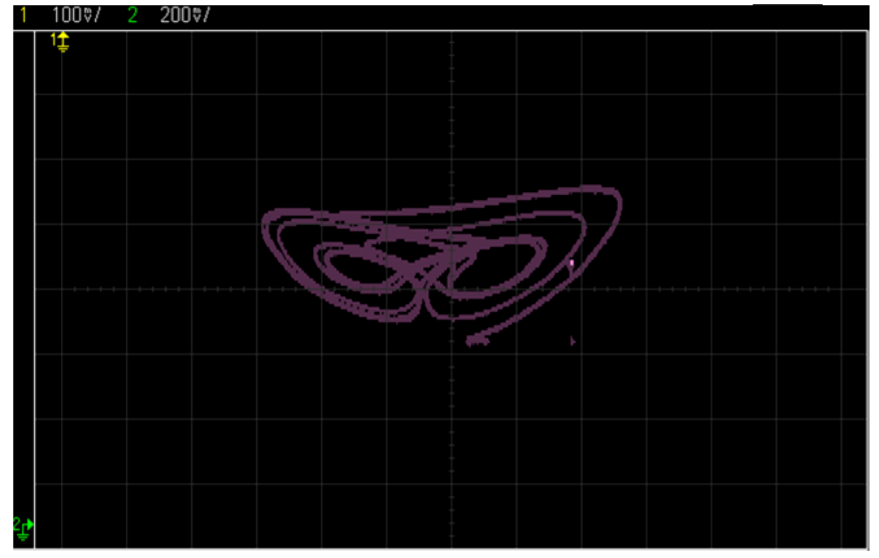
Figure 26. Strange attractor with x (cid:2871)(cid:3041) (cid:2869) (cid:3041) (cid:3364)(cid:3364)(cid:3364) and 𝑥 .